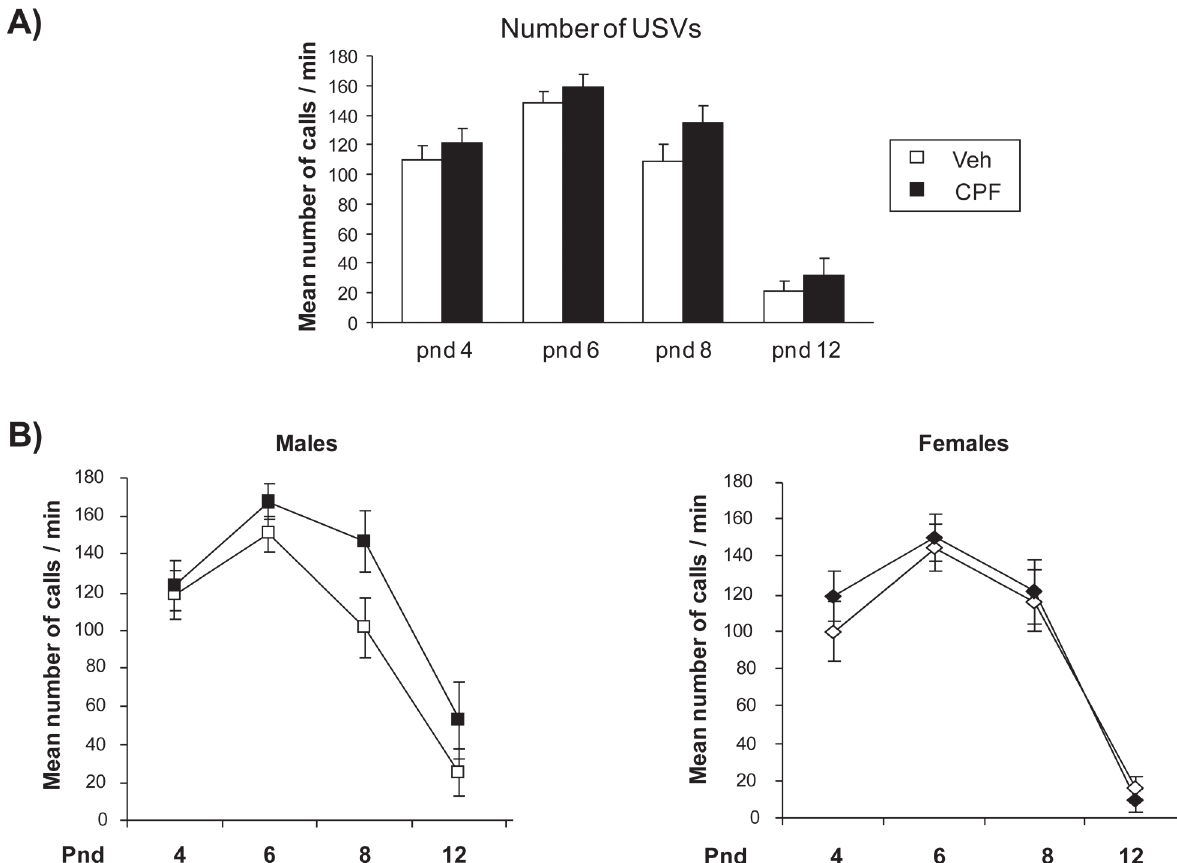
Fig 1. Ultrasonic vocalizations (USVs) in separated pups. A) Mean number of USVs emitted by CPF- and Veh-treated pups on postnatal day (pnd) 4, 6, 8 and 12 in response to three minutes of maternal separation. Data are expressed as mean number of calls/min ± SEM. Veh, n = 26; CPF, n = 23, including one male and one female deriving from each of the litters assigned to either treament. B) Mean number of USVs on pnd 4, 6, 8 and 12 emitted by CPF-treated and Veh pups of each sex. CPF tended to increase the rate of emission only in males. Data are expressed as mean number of calls/min ± SEM. Females: Veh, n = 13; CPF, n = 11; Males: Veh, n = 13, CPF, n =